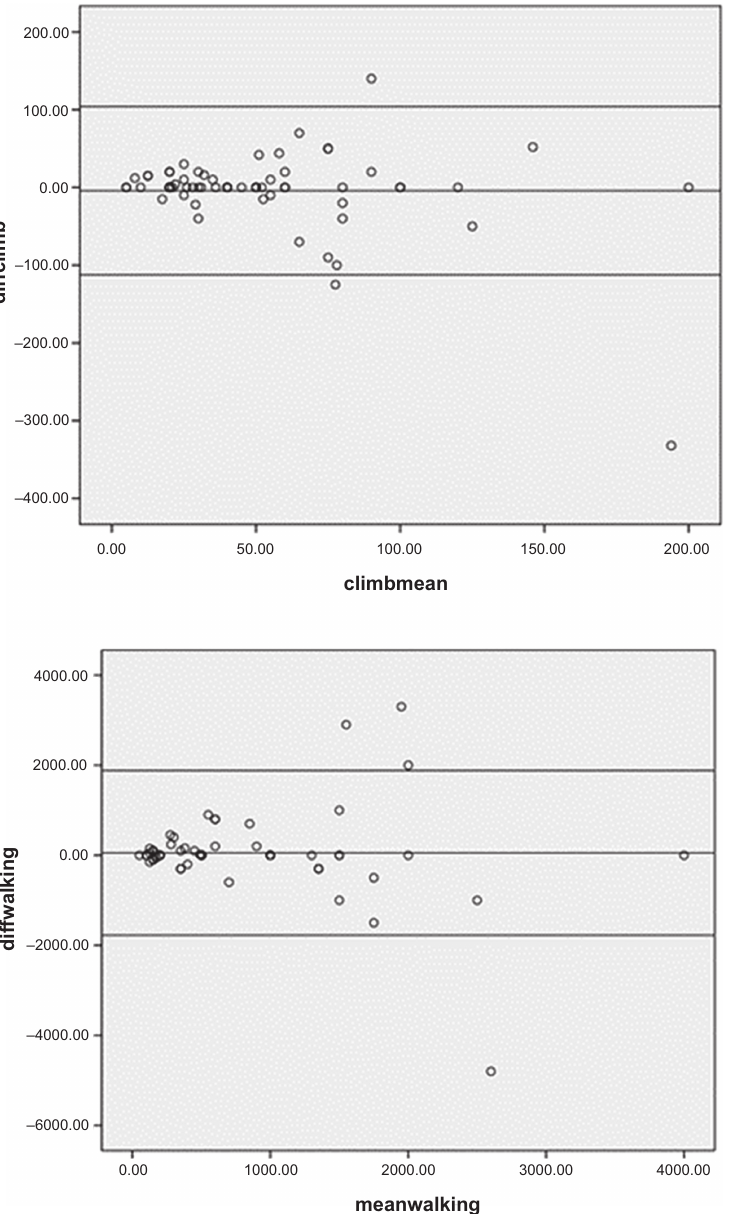
Figure 1. Bland – Altman plots showing limits of agreement between two sets of measurement at 14 days interval for numbers of stairs climbed per day (left- handside)anddistance of walking per day (right-hand